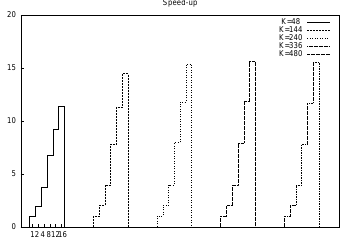
Figure 6. Results of the efficiency test for the McFadden problem with 900 spatial mesh